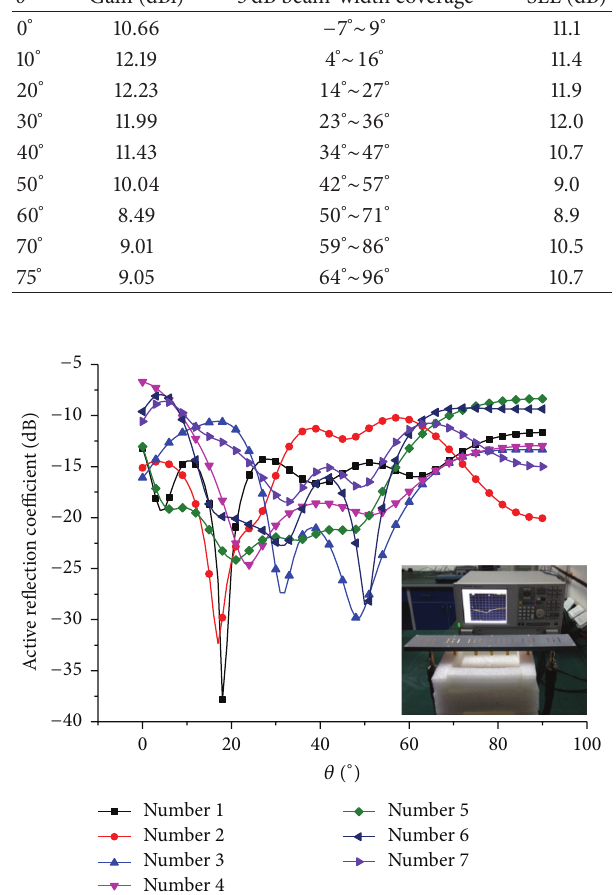
Figure 6: Measured active reflection coefficients of the seven- element phased